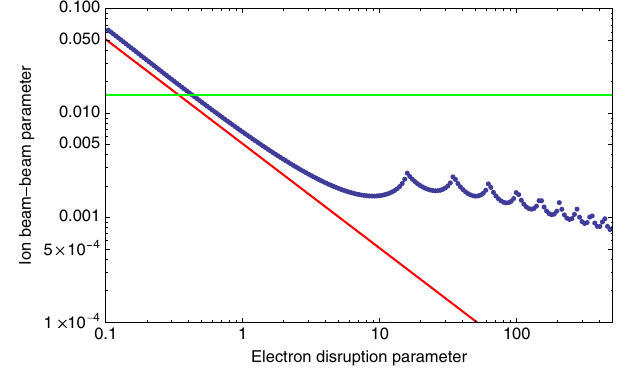
FIG. 3. The threshold of kink instability, with choice of the synchrotron tune 0.004. The blue dots denote the threshold calculated from 51 macroparticles circulant matrix method. The red line represents the simple threshold form from Eq. (12) with z 0 ¼ (cid:2) iz . The green line corresponds to (cid:6) i ¼ 0 : 015 , which is the design beam-beam parameter of the ion bunch in